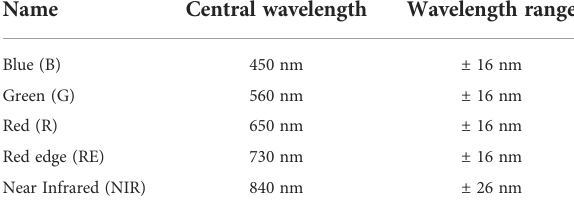
TABLE 1 Characteristic wavelengths of multispectral UAV remote sensing